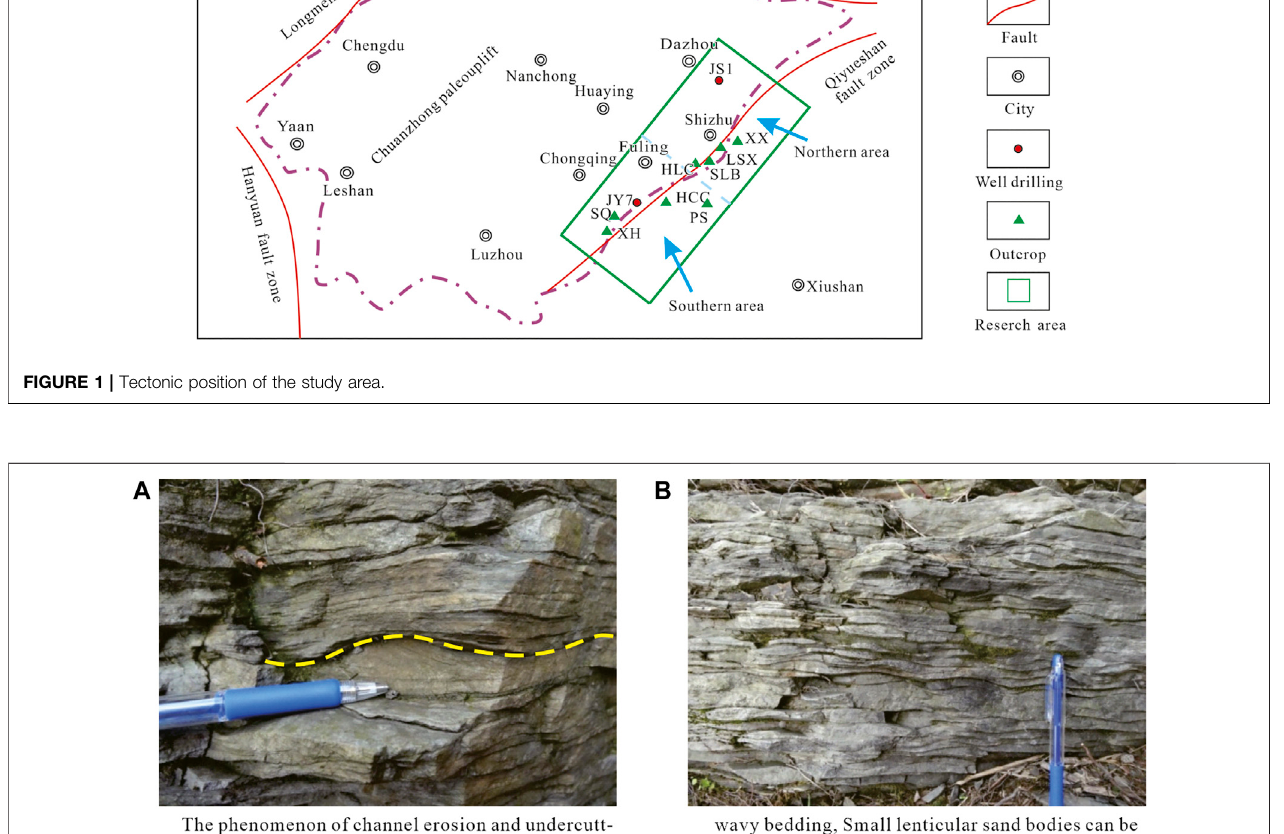
Frontiers in Earth Science |